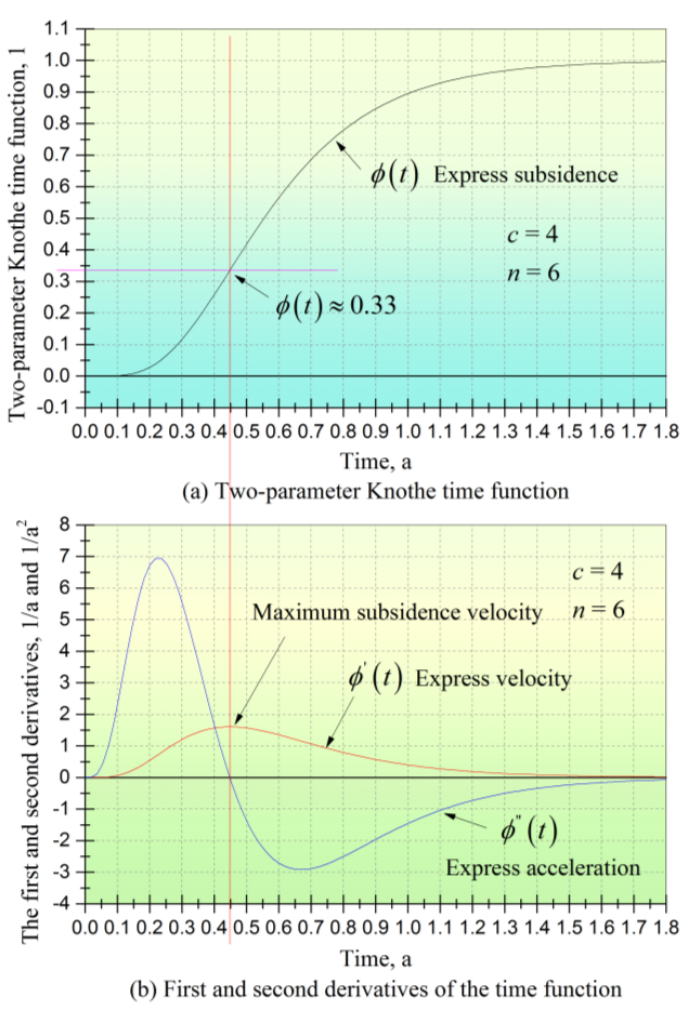
Figure 3. Graphical representation of the two-parameter time function and its first and second deriva- tives. ( a ) Two-parameter Knothe time function; ( b ) First and second derivatives of the time func- tion.